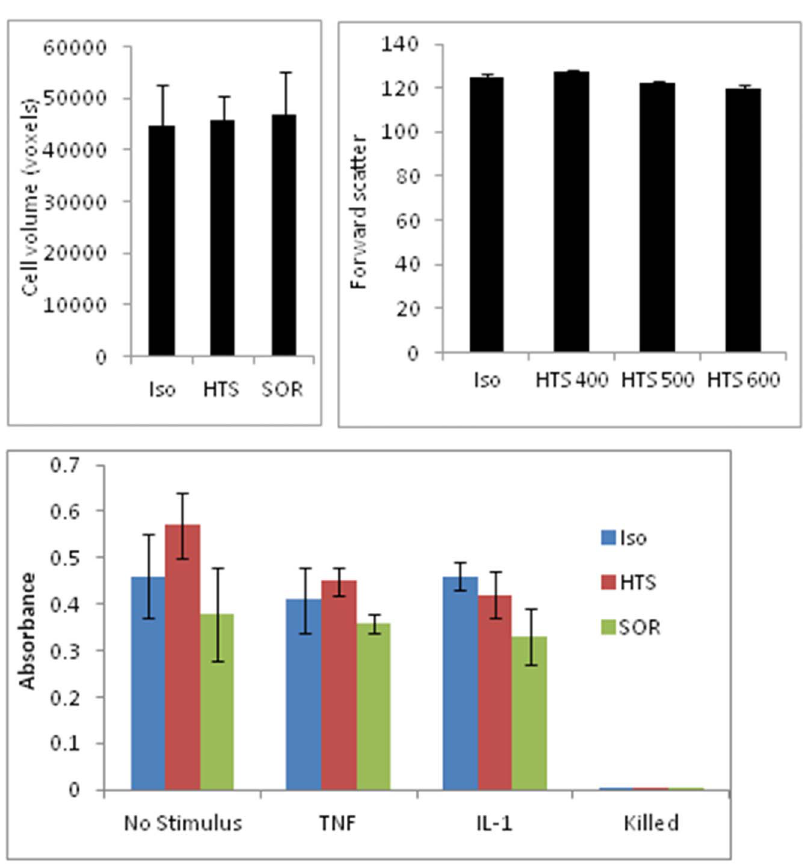
Figure 7. HOsm does not significantly affect cell volume. Top left panel shows the mean total cell volume of pulmonary epithelial cells measured by immunofluorescent microscopy is not changed in the presence of 400 mOsm HTS or SOR after 18 hours of incubation (n 5 3). The panel on top right shows mean ( ¡ sem) forward scatter of pulmonary epithelial cells measured by flow cytometry is also unchanged in the presence of isotonic and 400, 500, and 600 mOsm solutions of media plus HTS, after 18 hours of incubation (n 5 3).